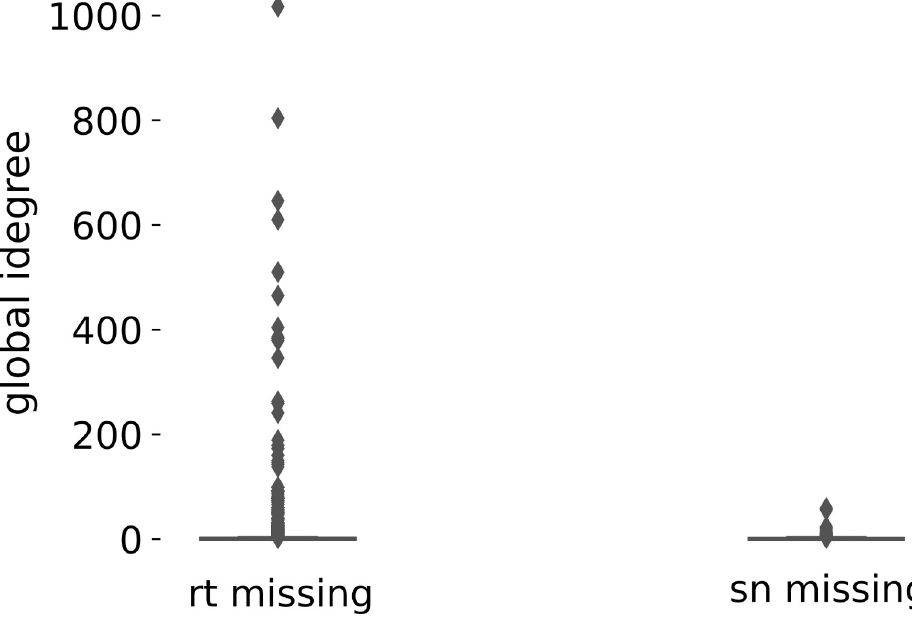
Fig 2. Missing users in retweet versus signed network. Distribution of the indegree of the users that an analysis of the largest connected component in the retweet network (left) or signed network (right) would miss.